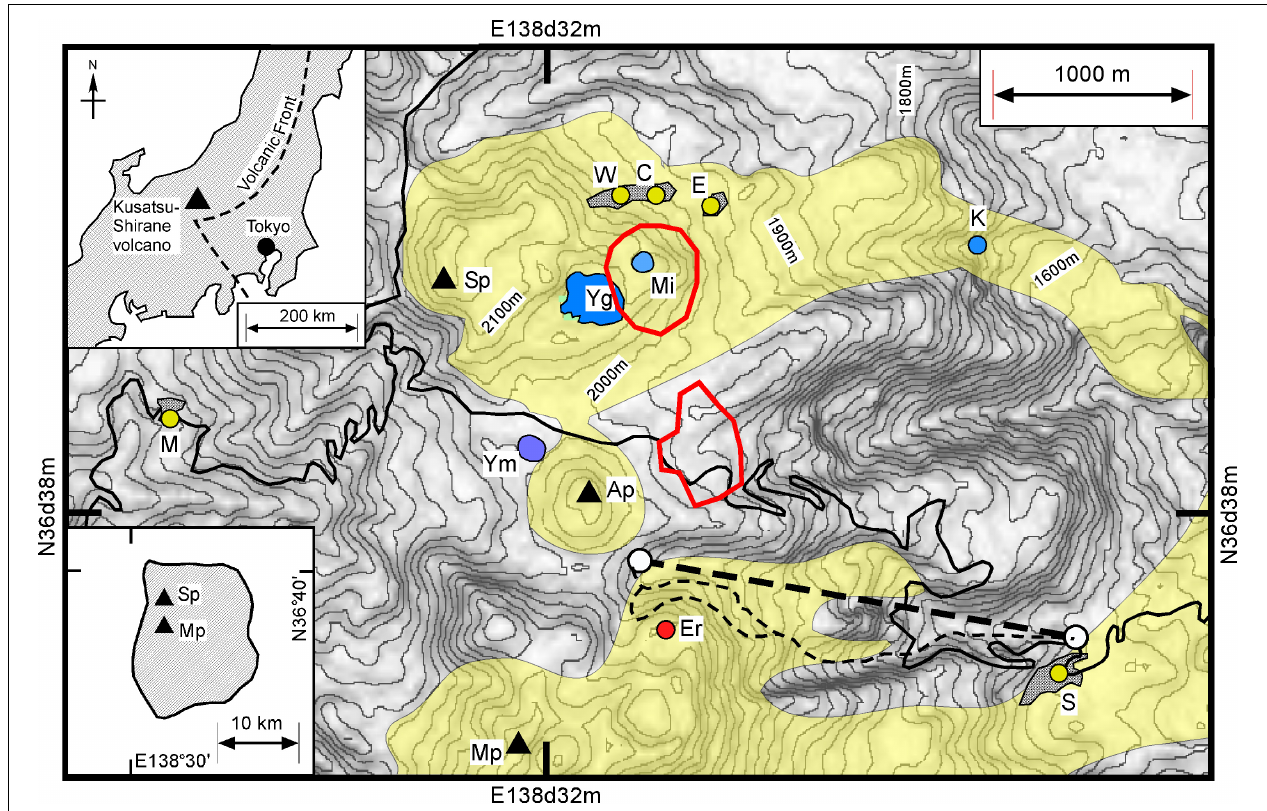
FIGURE 1 | Location of fumarolic gasses, W, C, E, S and M. The shaded regions overlapping the fumaroles indicate the region with geotherm. Yugama (Yg), Mizugama (Mi) and Yumiike (Ym) are craters with lake water. Sirane (Sp), Ainomine (Ap) and Motoshirane (Mp) are pyroclastic cones. The inserted figure on the upper left corner shows the location of Kusatsu-Shirane volcano on Island of Honshu, Japan with the volcanic front (Sugimura, 1960). The inserted figure on the lower left shows the distribution of lava and pyroclastic deposits emitted from Kusatsu-Shirane volcano, which are younger than 1,4000 years (Uto et al., 1983). The yellowish areas indicate the lava and pyroclastic deposit younger than 7,000 years (Hayakawa and Yui, 1989). The hypocenters of volcanic earthquake are distributed within the two bold red circles (HP of Japan Meteorological Agency (JMA), https://www.data.jma.go.jp). The hypocenters of the volcanic earthquakes cluster at a depth between sea level and up to 2000 m above sea level. A small steam explosion occurred at Er in January 2018. K is the position of hot spring water which contains high concentration of Cl − . Ohba et al. (2000) suggested K represents the liquid phase of the hydrothermal system beneath Crater Yugama. The bold broken line shows the ropeway. Thin broken curves indicate the ski slopes. The altitude interval of the contour line is 20 m. The thin solid curve indicates the car road.